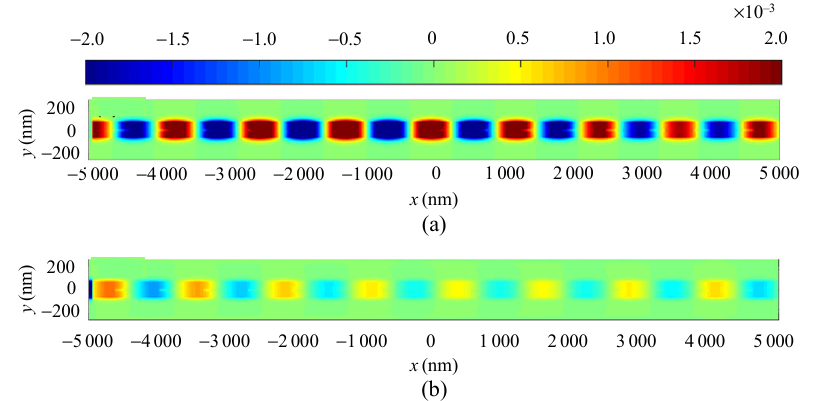
Fig. 4 Magnetic field distributions of the grating at (a) 1 440 nm and (b) 1 550 nm.